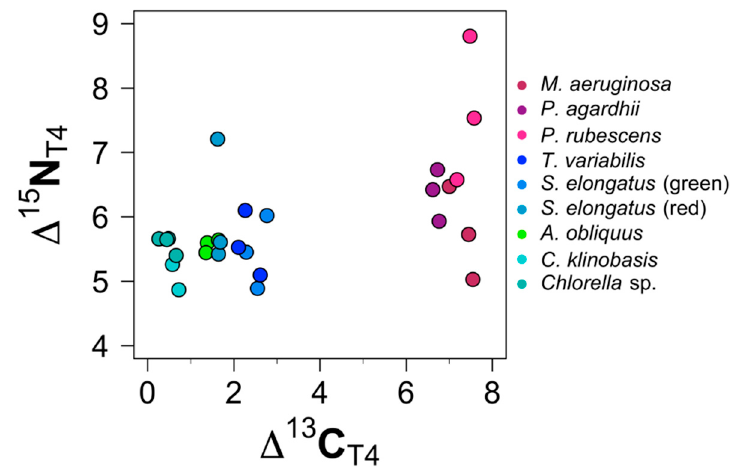
Figure 5. Discrimination factor ( ∆ ) values for stable carbon and nitrogen isotopes 96 h ( M. aeruginosa 72 h) after the dietary switch.